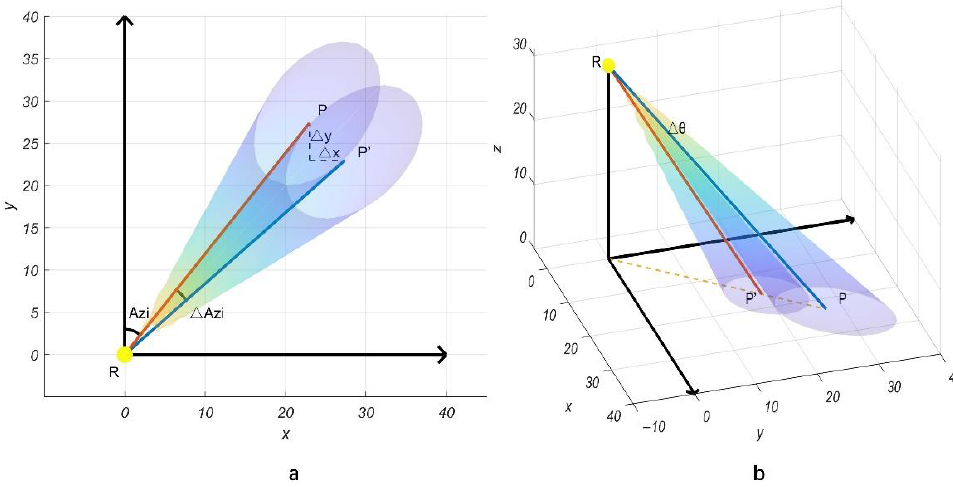
Figure 9. Schematic diagram of radiometer field of view ( a ) azimuth angle change (top view) and ( b ) incident angle change.